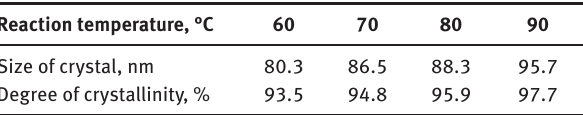
Table 3: Effect of reaction temperature on size and crystal degree of HA.